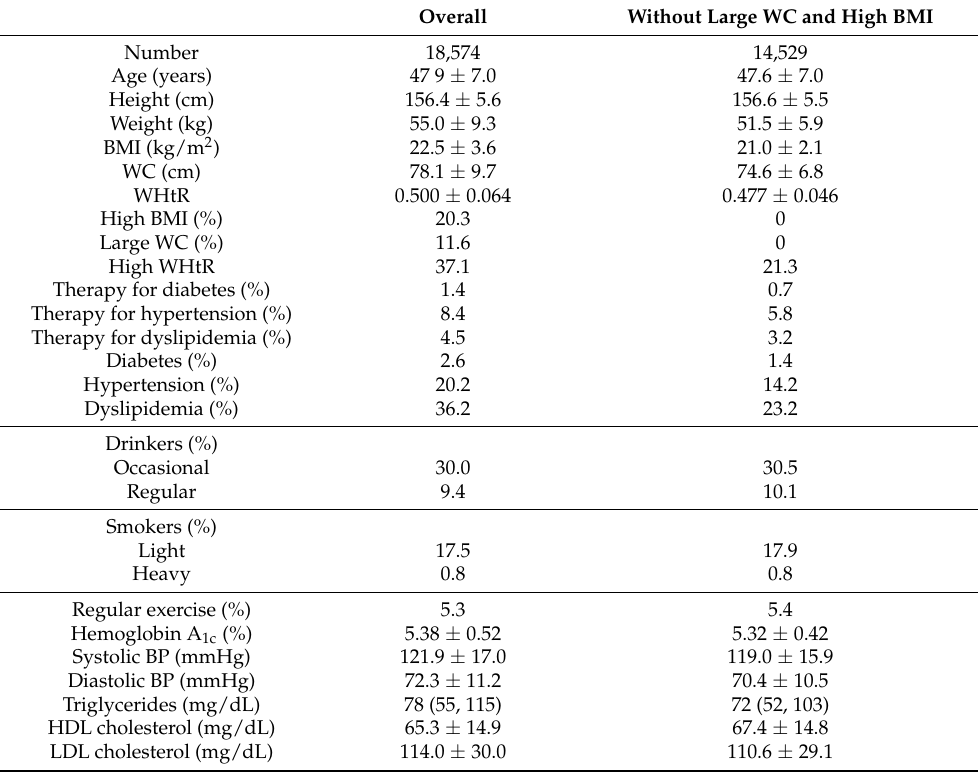
Table 1. Characteristics of the overall subjects and subjects not showing large waist circumference and high BMI.